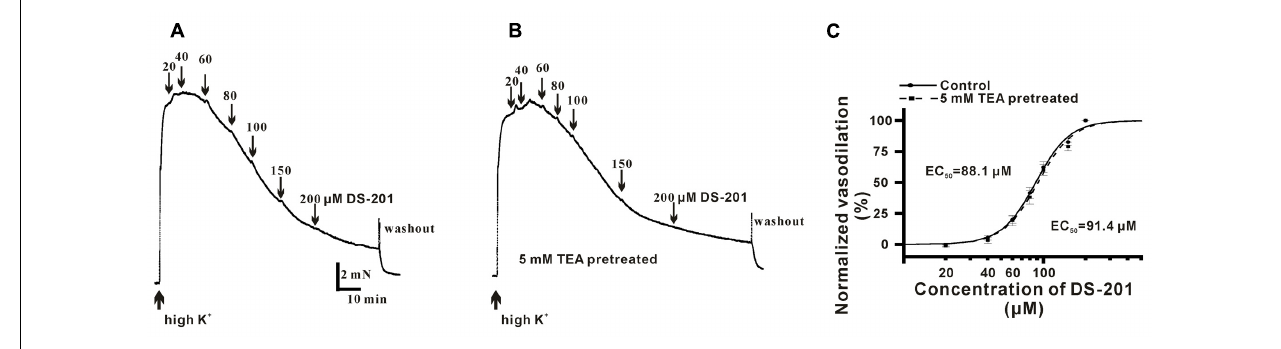
FIGURE 2 | Effect of DS-201 (20–200 µ M) on vasodilation in high K + -preconstricted artery rings. (A) The typical recordings show that DS-201 relaxed high K + -preconstricted artery rings in a concentration-dependent manner. (B) The typical recordings show that TEA (5 mM) did not affect the effect of DS-201 on vasodilation and (C) Concentration-response curves show that TEA did not shift the curve. The data were obtained with eight artery rings from six